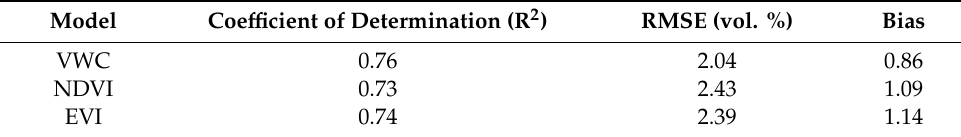
Figure 12. The correlation of the soil moisture between simulation and measured values ( a ) VWC; ( b ) NDVI; ( c ) EVI. Table 6. Statistical metrics between in situ and simulation soil moisture.